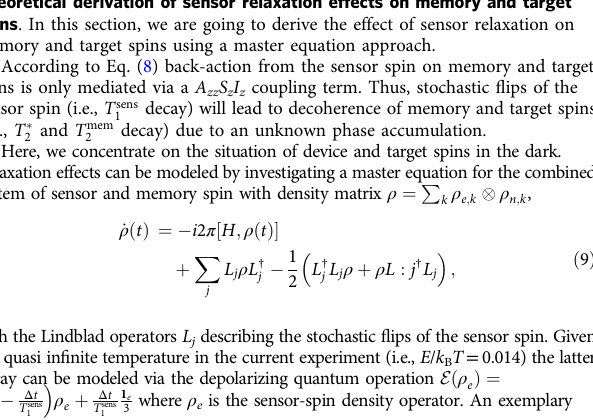
Fig. 6 Decay constants of sensor, memory, and target. a Lifetime of the memory spin. The uppermost graph shows the T mem show two different decay constants, 0.49 and 180 s. The fast decay corresponds to those measurement runs, during which the NV center resides in the NV 0 charge state, the slow decay corresponds to the NV − case. By using charge state readout (see ref. 37 ) and data post selection, one can isolate pure NV 0 and NV − measurements. The results for 1.5 T are shown in the middle (NV 0 ) and lower (NV − ) line. b The sensor performance, including the coherence of the probed spins, without any dissipative decoupling. The uppermost line shows the coherence decay of the memory spin, with a decay = (8.6 ± 1.3) ms. Below, the orange lines show (from top to bottom) the coherence ( T sens constant of T mem 2 = 6.4 ± 0.6 ms) of the sensor spin. The black line shows the coherence of the target spins (without any decoupling from sensor dissipation), with a decay = 6.78 ± 1.3 constant of T (cid:2) 2